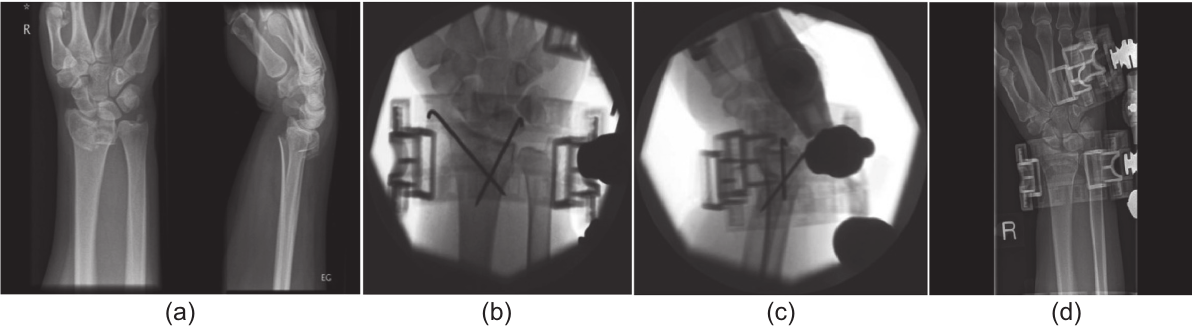
Figure 1. Radiographs and fluoroscopic images of a 35-year-old female patient with unstable intra-articular DRF (a) treated with non- invasive dynamic external fixator after closed reduction and percutaneous K-wire fixation (b and c). She had wires removed at three weeks post-op with continuation of non-invasive external fixator in dynamic mode (d) for further three weeks.